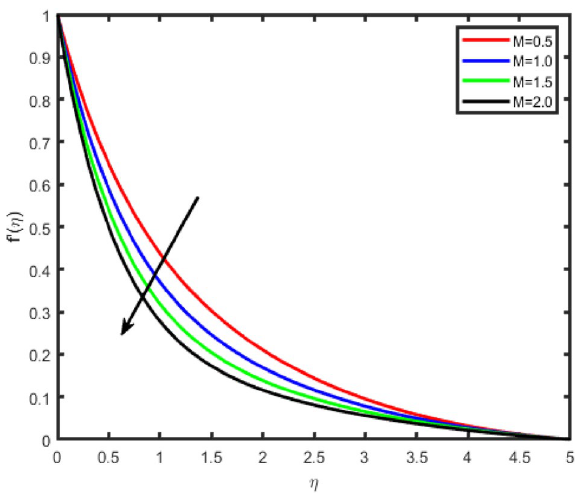
Figure 2. Effect of magnetic field parameter (M) on tangential velocity f ′ (η).